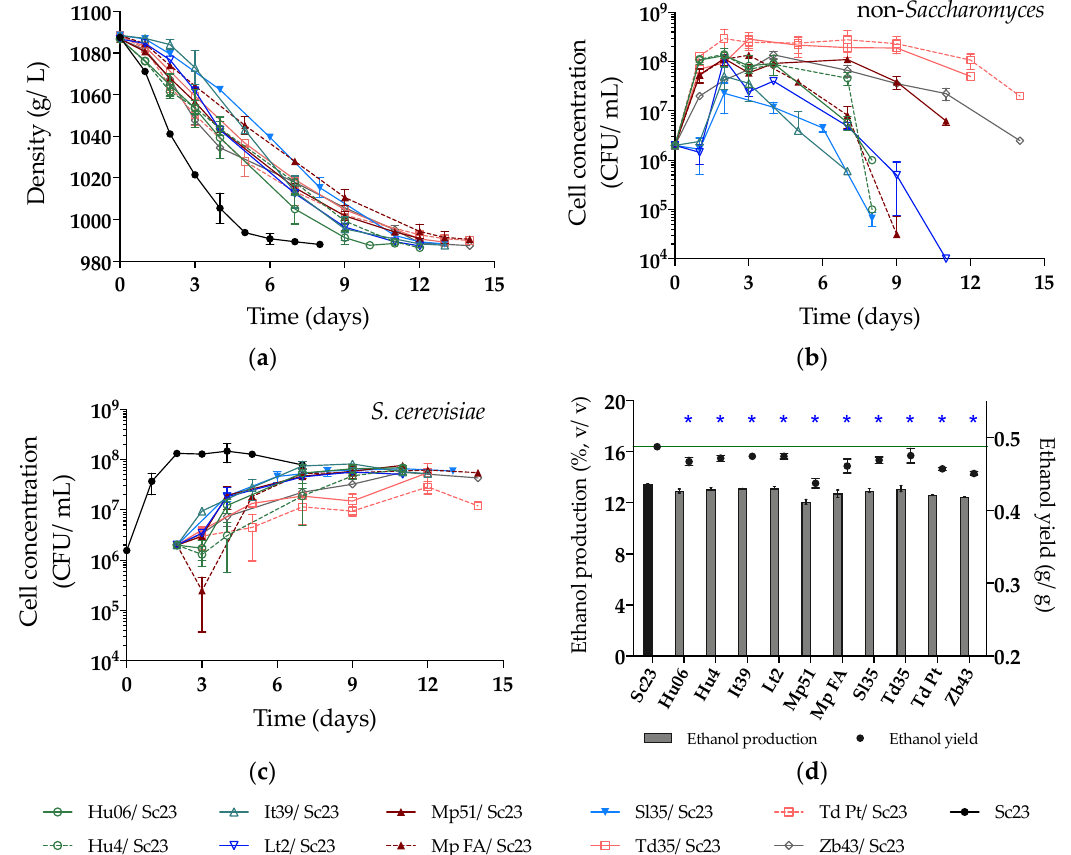
Figure 4. ( a ) Density (g / L); ( b ) Yeast population of non- Saccharomyces ; ( c ) Yeast population of Sc23 and ( d ) Ethanol production (%, v / v) and yield (g / g) during sequential fermentations in natural must. The value of the green line in Figure ( d ) is 0.49 g / g (ethanol yield of Sc23). Asterisks (*) show the significant di ff erence of ethanol yield compared with Sc23 (LSD, p < 0.05).